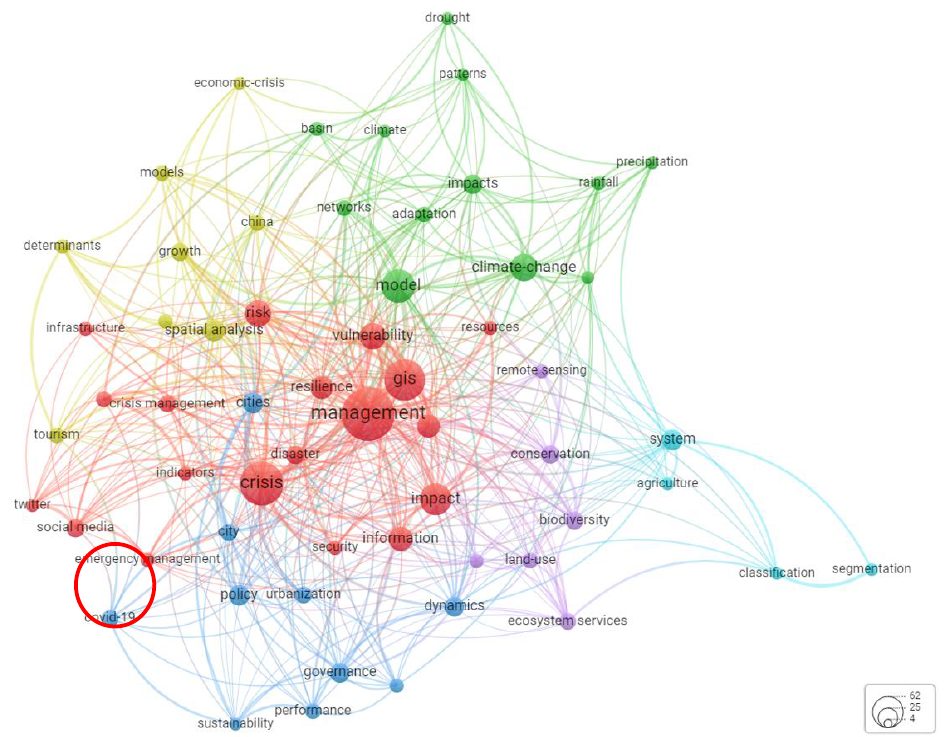
Figure 1. Weighted network visualisation of associations between terms within “crisis management spatial analysis” keyword relations (own study).